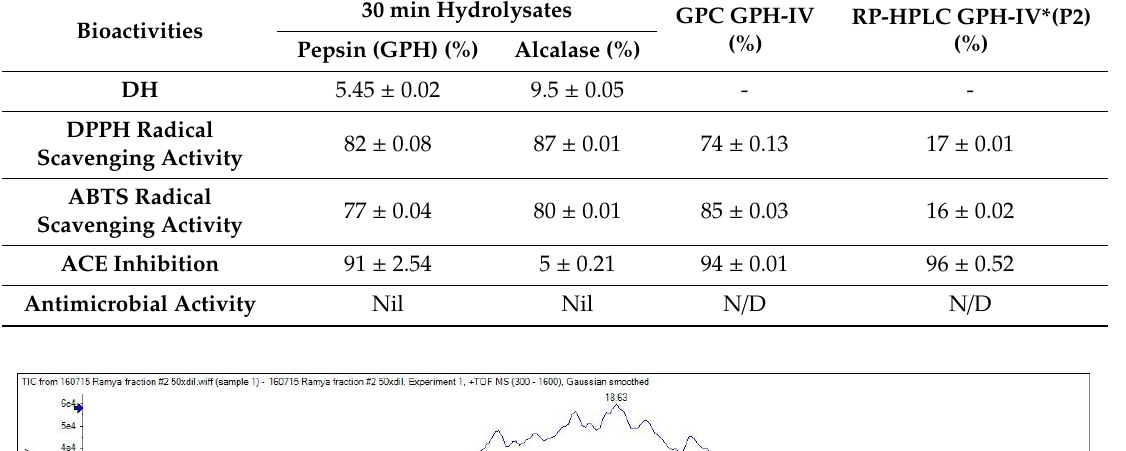
Table 1. Summary of the bioactivities of di ff erent hydrolysates and after each purification step. N / D: Not Determined.